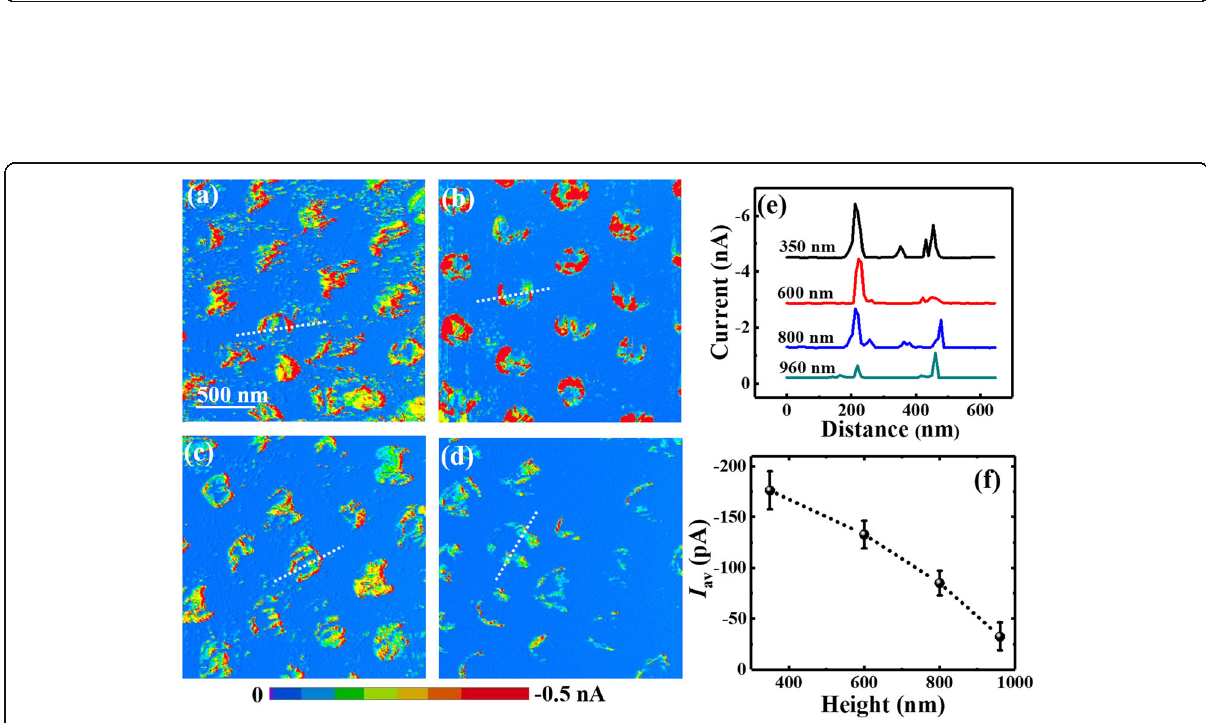
Fig. 5 The current images of Si NWs under the sample bias of − 1.5 V with the same diameter of 190 nm but different lengths of a 350 nm, b 600 nm, c 800 nm, and d 960 nm, respectively. The current profiles along the marked lines in a – d are plotted in e , and f presents the averaged currents of the nanowires ( I av ) as a function of NWs ’ length. The profile curves in e are vertically shifted for